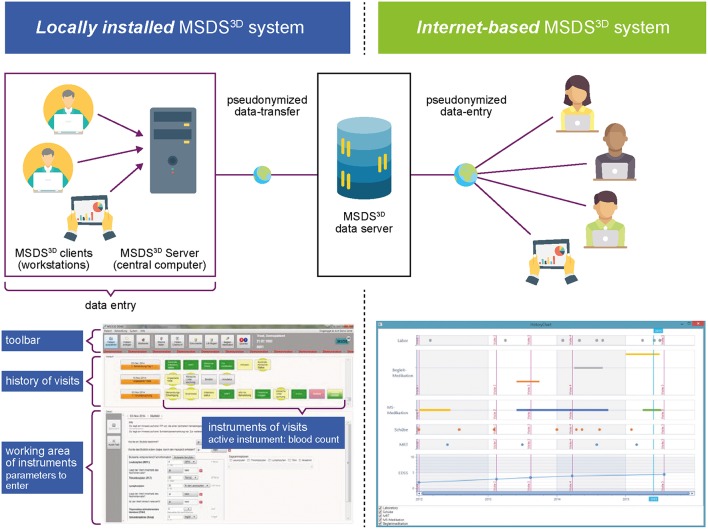
MSDS3D patient data management system. Reprinted from Ziemssen et al. (49). Creative Commons Attribution 4.0 International Public License.